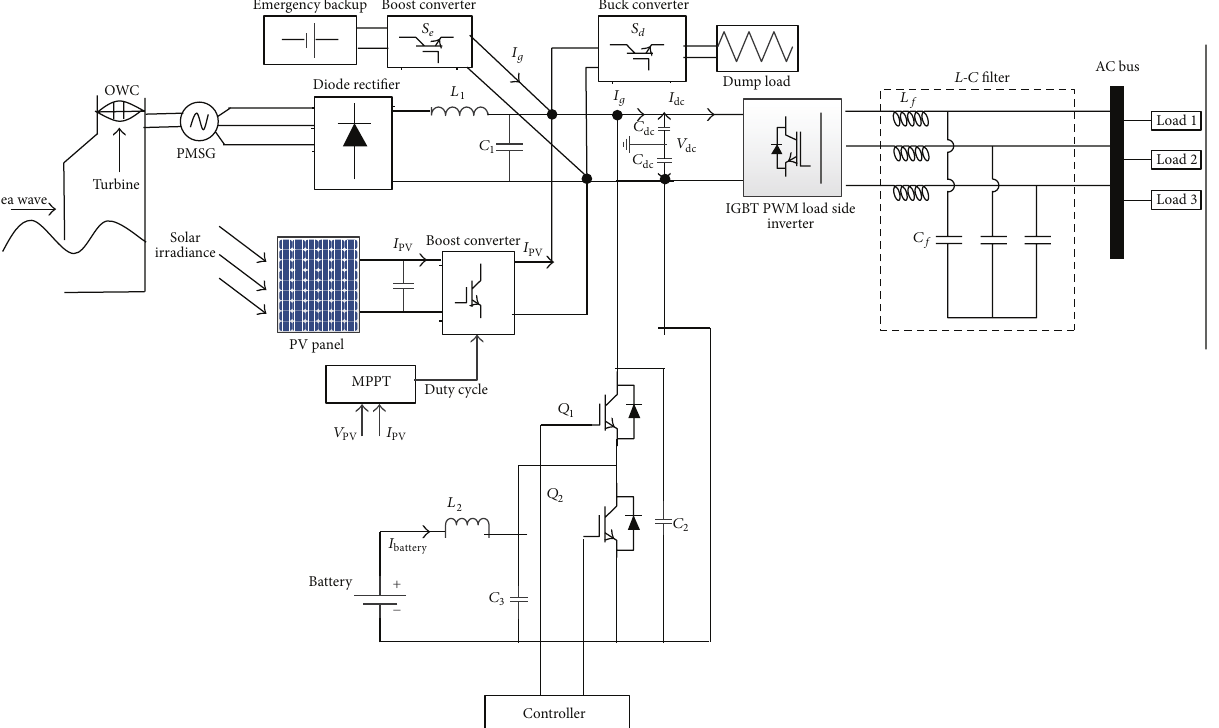
Figure 11: Circuit topology of the proposed PV-wave hybrid standalone system with emergency backup and dump load.